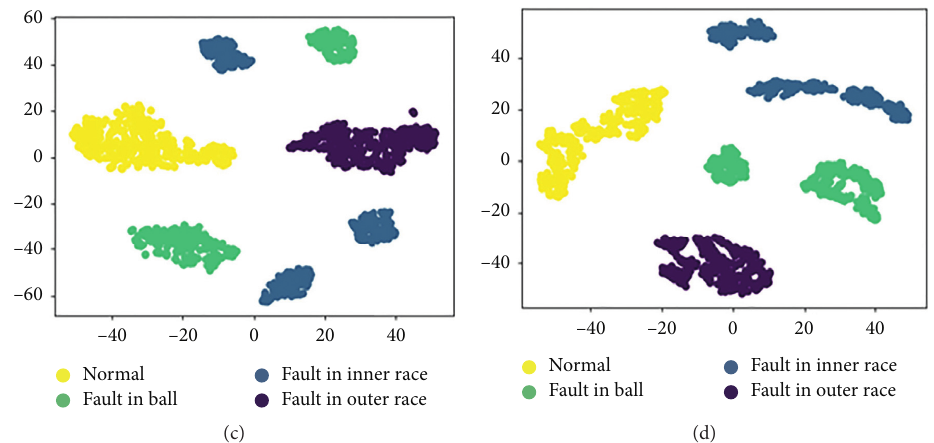
Figure 9: Partial convolutional layer output visualization. (a) Output of conv_1. (b) Output of conv_3. (c) Output of conv_4. (d) Output of fully connected